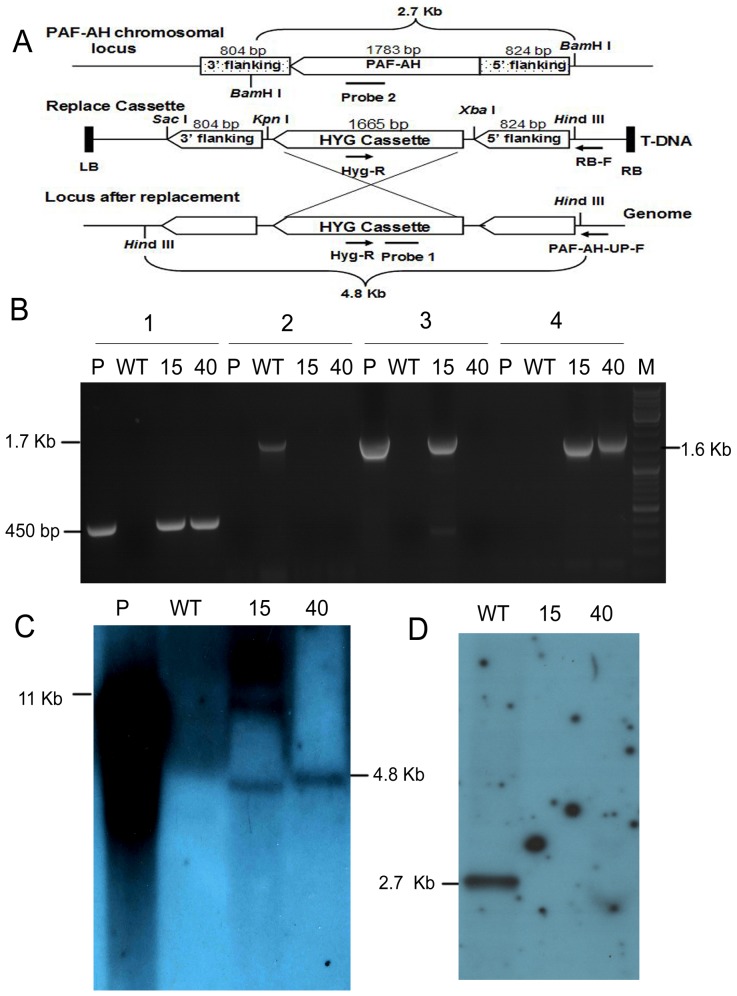
Screening of PAF-AH knockout transformants.(A) Physical map of homologous recombination. (B) Identification of transformants by PCR: 1, fragment of the hygromycin B resistance gene (hyg); 2, amplified fragment of PAF-AH from genomic DNA; 3, amplified T-DNA fragments adjusted to the right border of plasmid; 4, fragment amplified with primers PAF-AH-UP-F and Hyg-R. (C) Southern blot to verify T-DNA insertion copies of knockout transformants. The 450 bp fragment amplified from the hyg gene was labeled with 32P-dCTP as probe 1. (D) Southern blot to confirm PAF-AH was replaced using the 500 bp fragment of PAF-AH as probe 2. WT, wild type strain; P, plasmid; KO15 and KO40: PAF-AH knockout transformants; M: DNA marker.